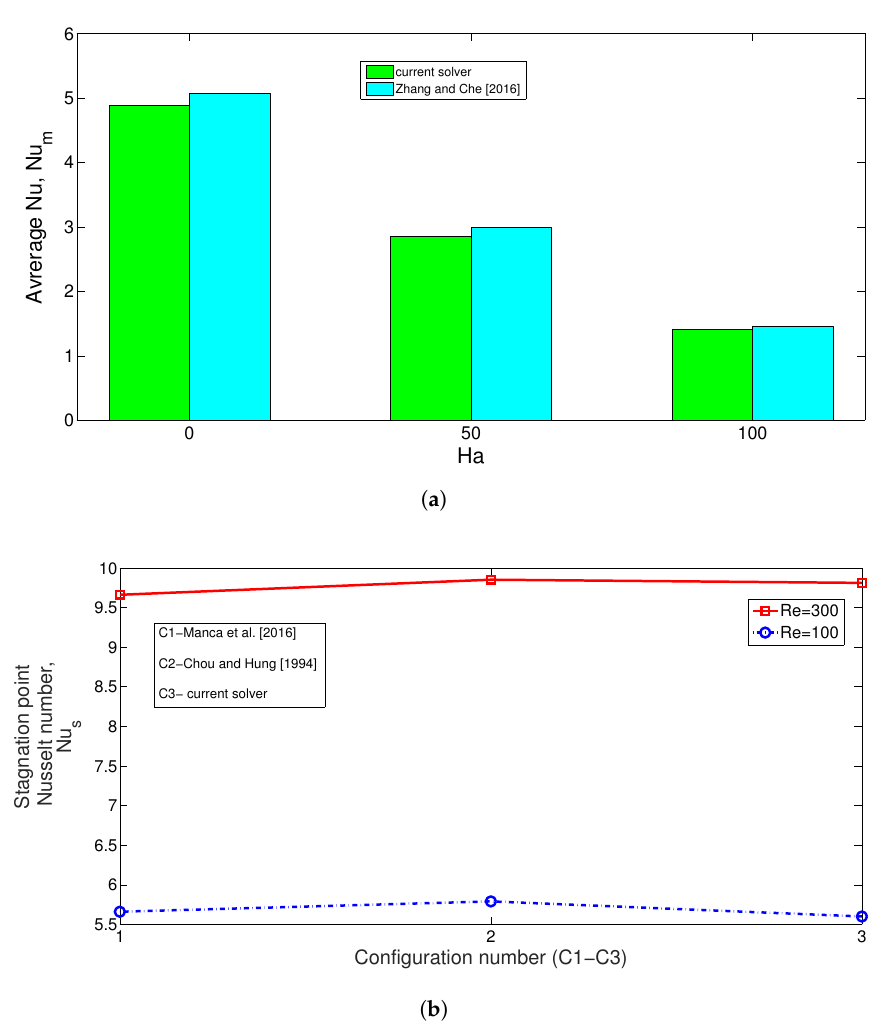
Figure 4. Code validation 1: Average Nu comparisons at three different Ha considering the convec- tion in a differentially heated enclosure. Results in [42] are used, and Grashof number is fixed to Gr = 2 × 10 5 ( a ). Code validation 2: Stagnation point Nu comparison for SJ-I cooling of an isothermal surface by using the reference results in [43,44] at Reynolds number 100 and 300 ( b